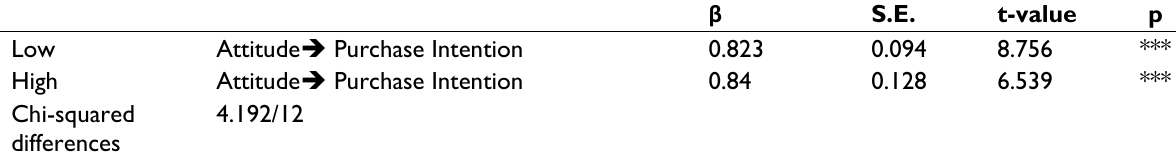
β S.E. t-value p